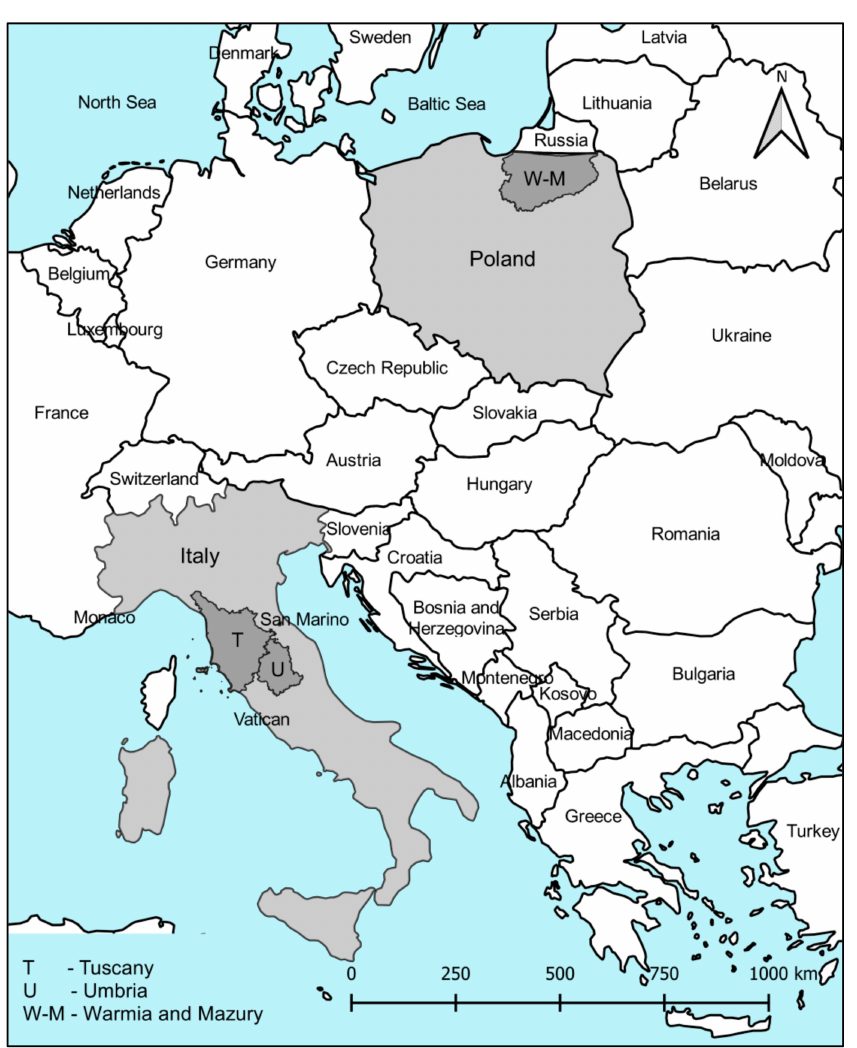
Figure 1. The analyzed regions. Source: own